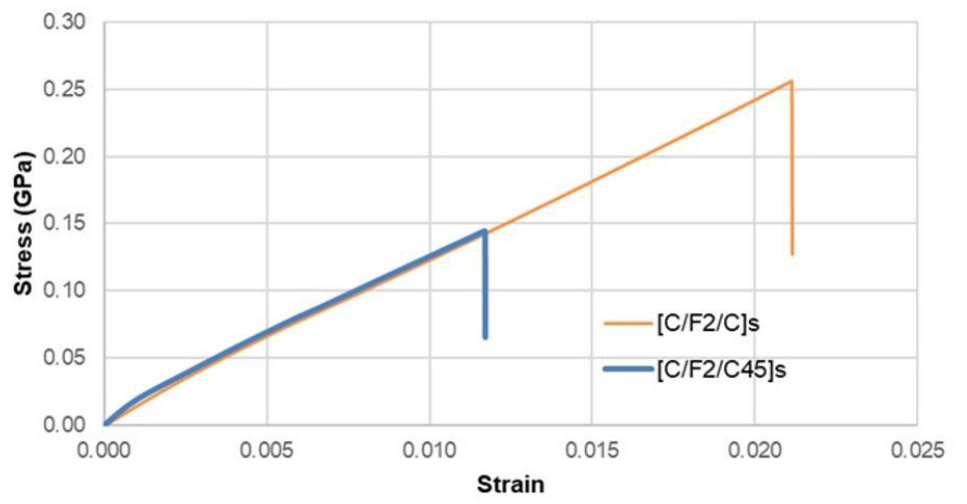
Figure 5. The comparison of stress-strain relationship for [C / F2 / C] s laminate against [C/F2/ C ±45 ] s laminate.